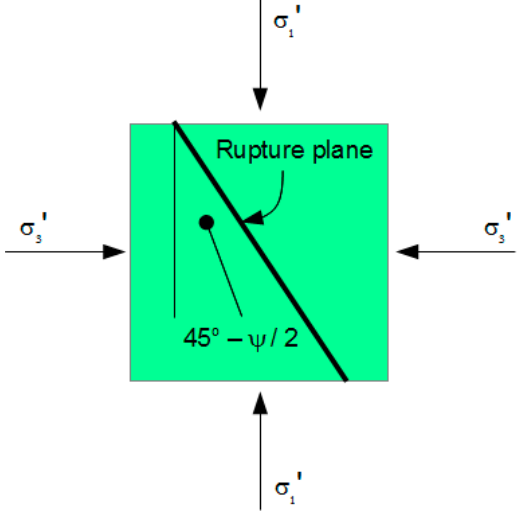
Figure 6. The Rupture Plane.